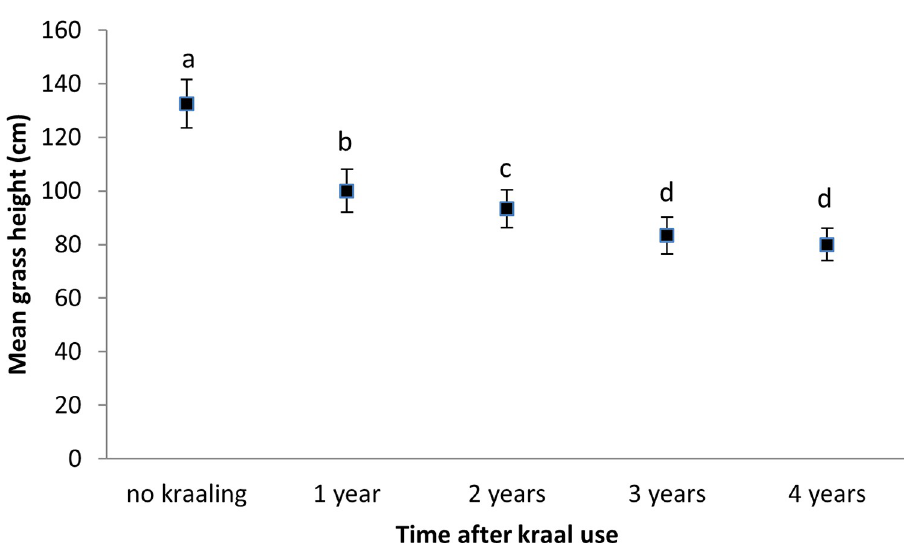
Fig 5. Mean ( ± SE) grass height in nutrient enriched hotspots of different ages. Similar letters show that there were no significant differences between the treatments.